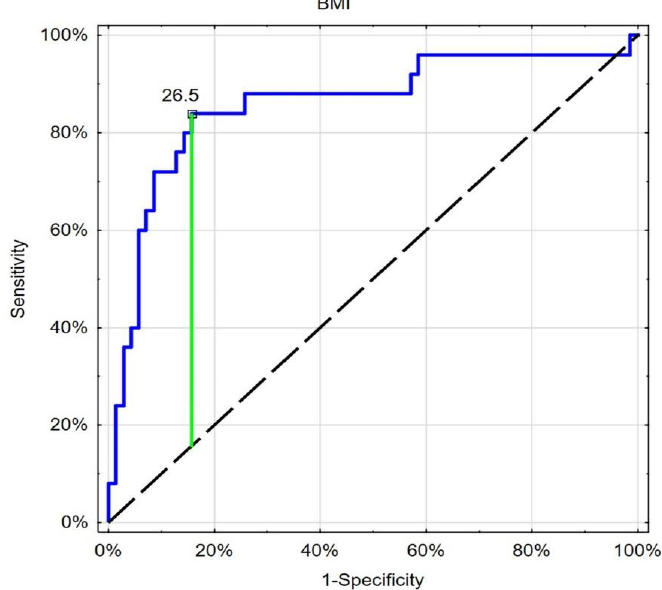
Figure 1. ROC analysis (blue line) of BMI in the differentiation between type 1 or type 2 diabetes, with the best cut-off point based on the Youden index (green line). Black dashed-reference line.